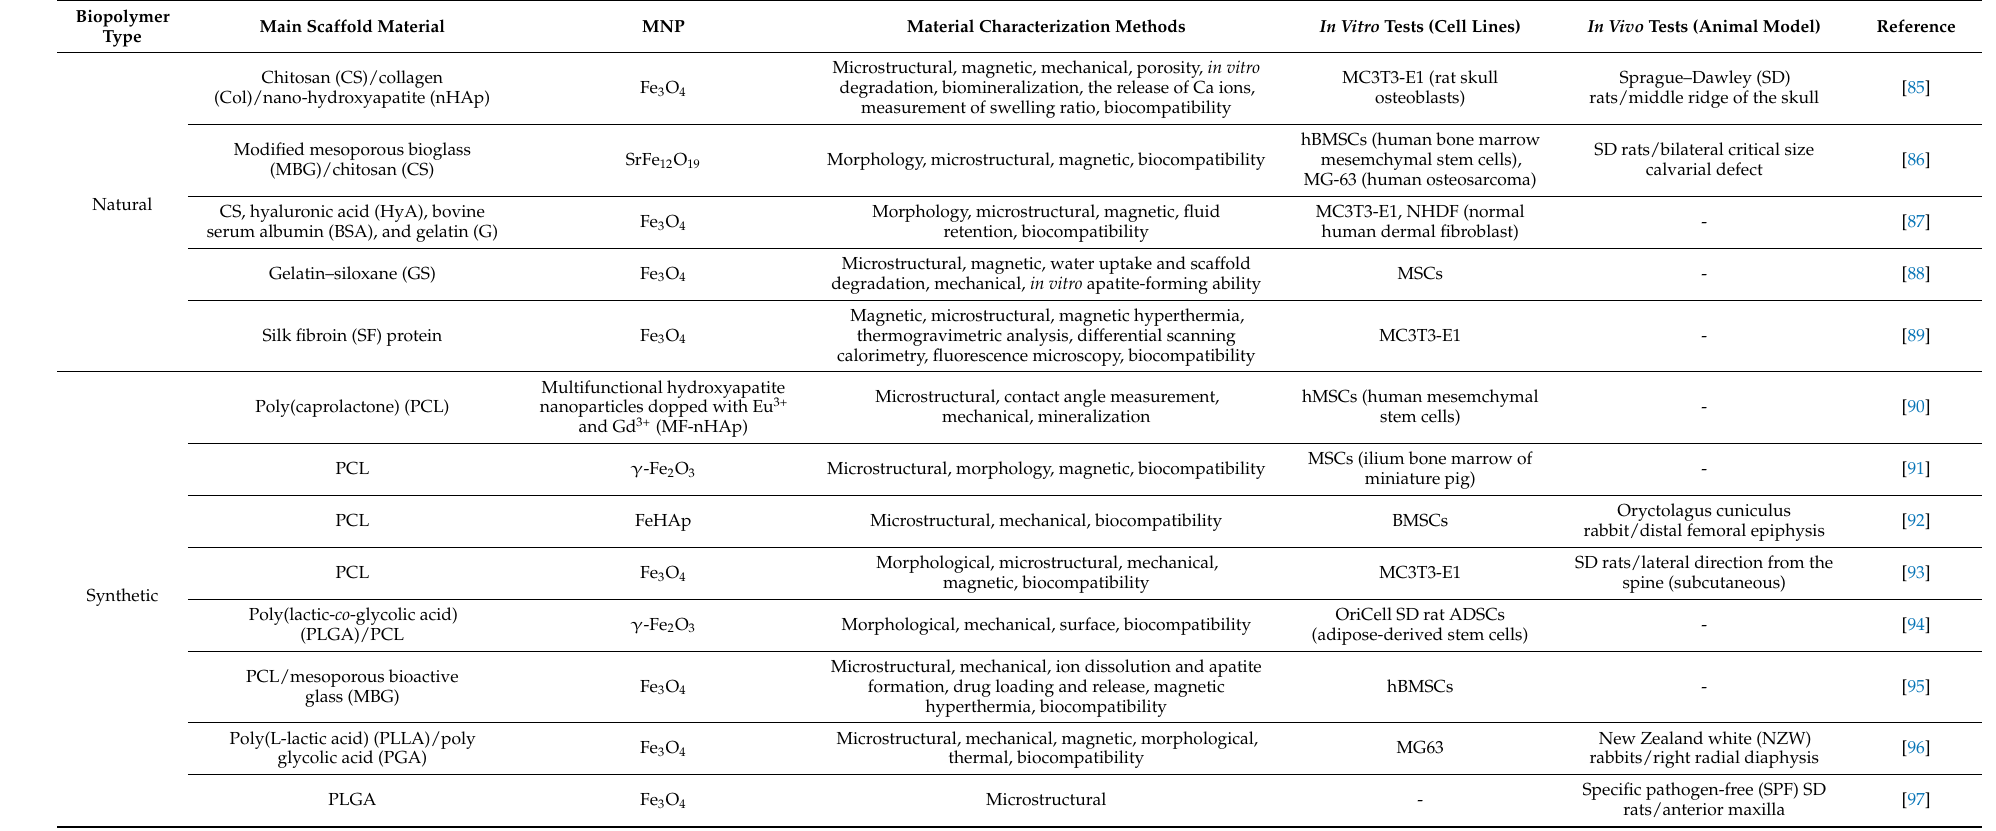
Table 1. Studies regarding magnetic scaffolds based on biopolymers and